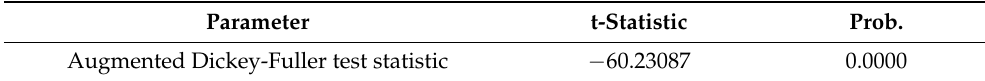
Table 5. Unit Root Test of the Residual Series.